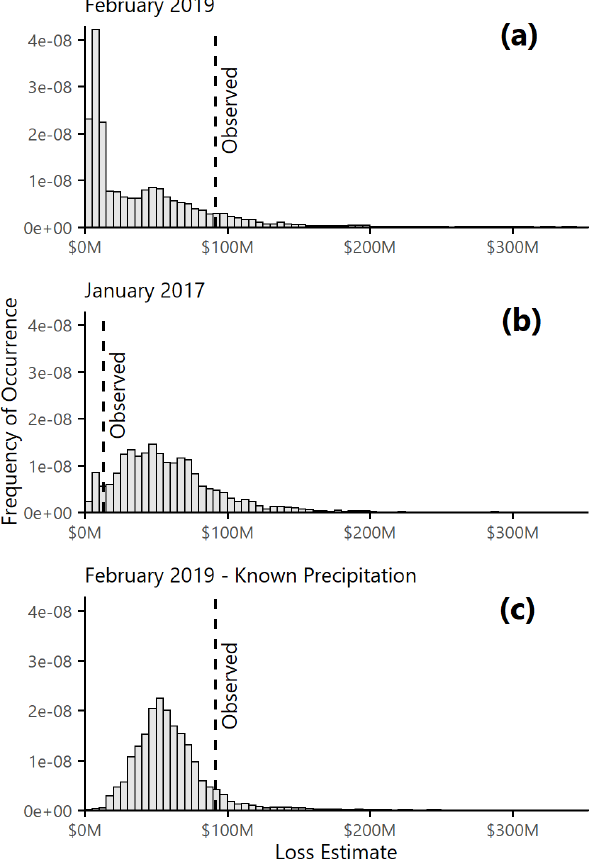
Figure 9. PARRA simulated loss results. Observed vs. simulated losses for (a) the Category 3 February 2019 event, (b) the Cate- gory 5 January 2017 event, and (c) a modified version of the Febru- ary 2019 event with perfect information about expected precipita- tion. In each plot the vertical dashed line marks the observed loss